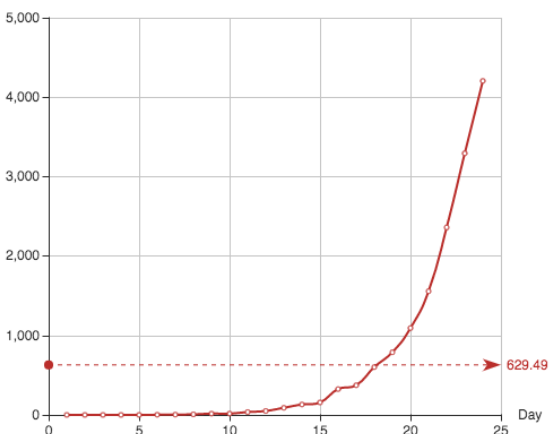
Figure 3. Actual data of the cumulative sum function E , that is, the cumulative sum of the dead plus recovered individuals. The dashed line corresponds to the average.